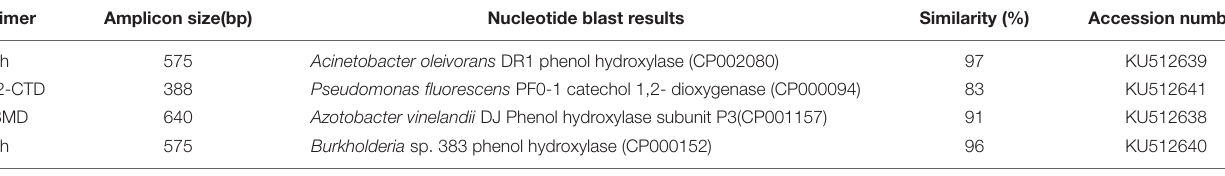
TABLE 2 | Basic local alignment search tool (BLAST) results of the phenol degradation gene sequences in the final enrichment culture C and the strain DW-1.